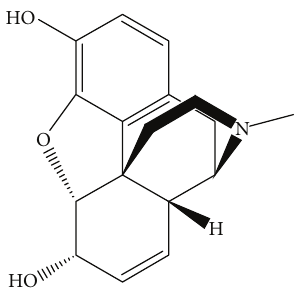
Figure 1: The structure of